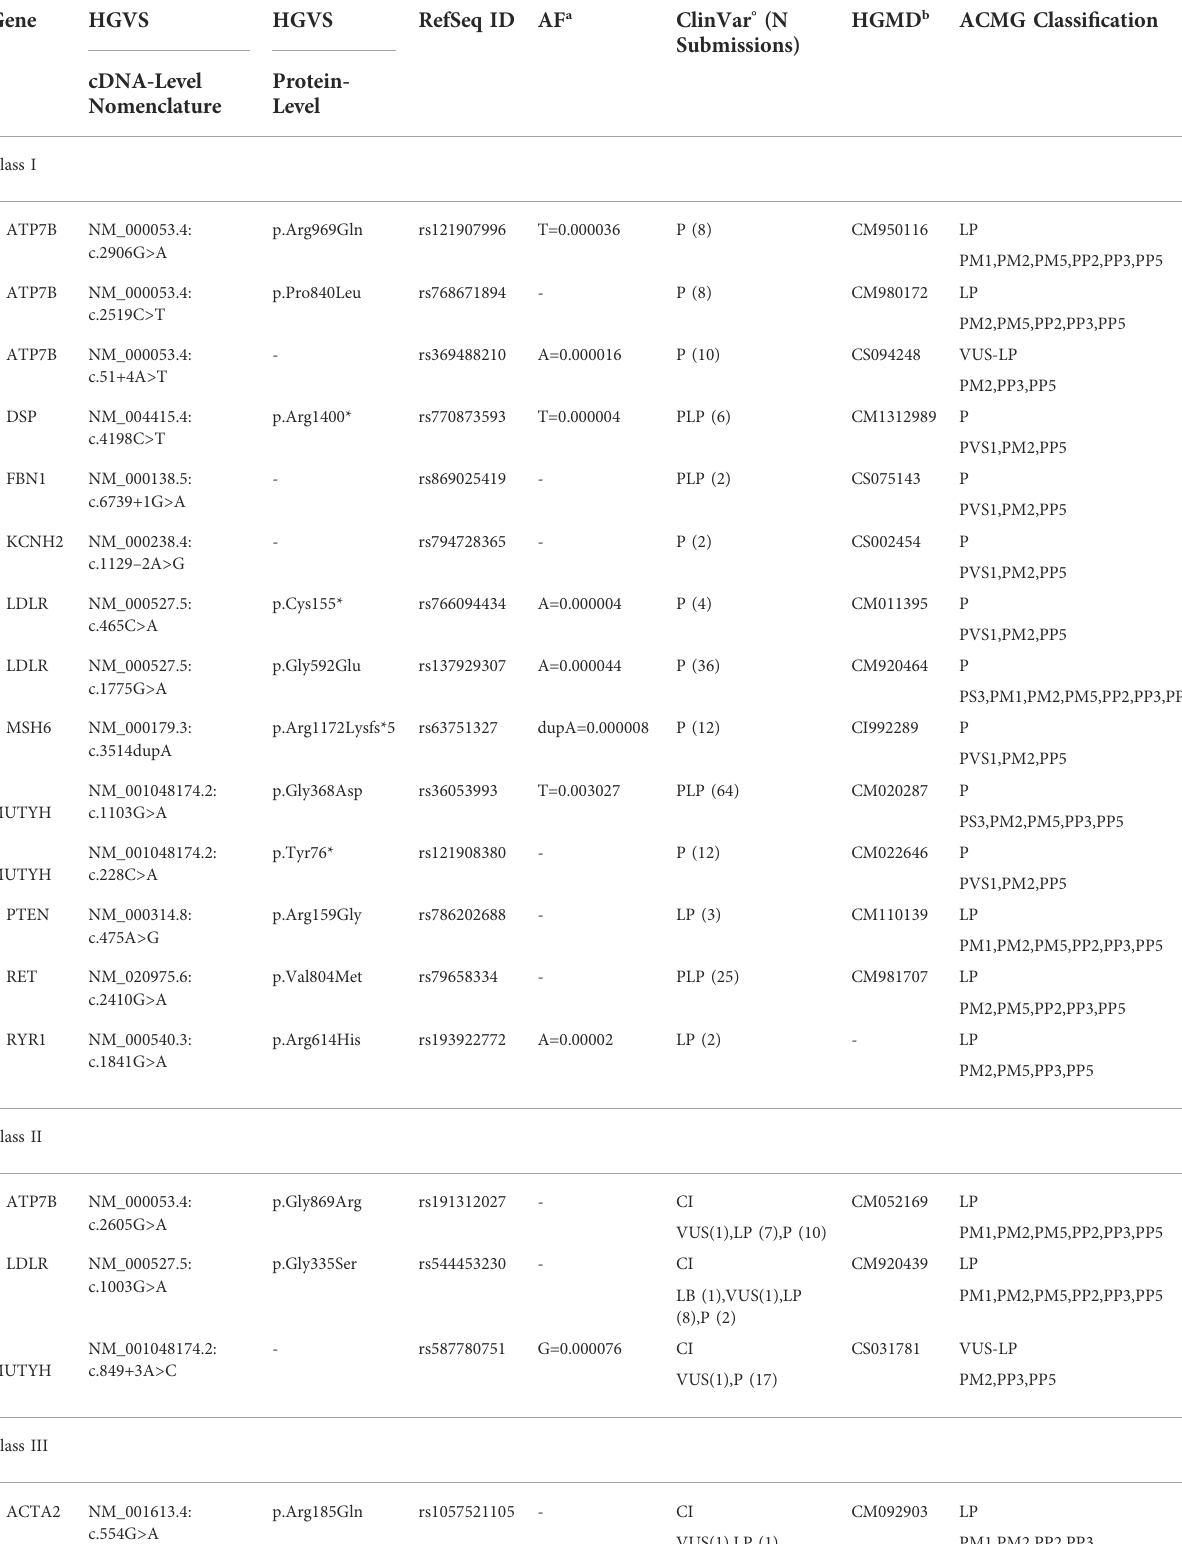
TABLE 2 Clinical exome medically actionable secondary fi ndings identi fi ed in 383